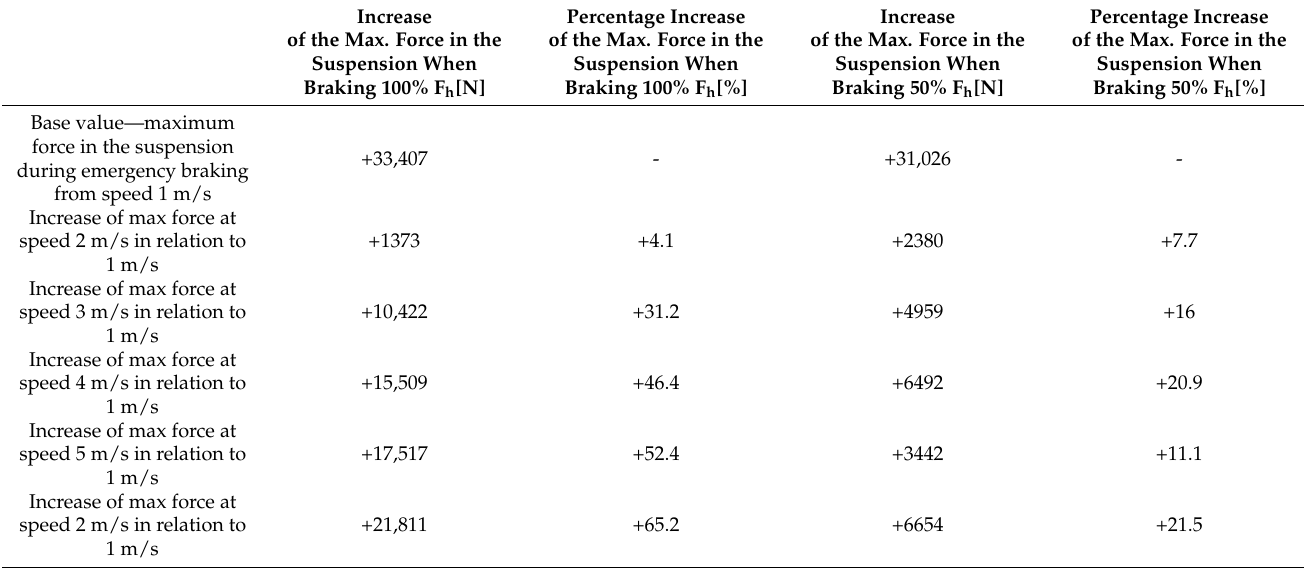
(Table 4) and in relation to the maximum speed of the suspended monorail, accepted by the legal regulations during transportation of people, i.e., 2 m/s (Table 5). The tables show the base value to which the other values were compared. The difference in forces was presented as force increase expressed in [N], and as a percentage increase in relation to the base value, both in relation to the simulation with full braking force and simulation in which the braking force was reduced by 50%. Table 4. Increase of maximum force in the most loaded suspension in relation to the force recorded during emergency brake from the speed 1 m/s.